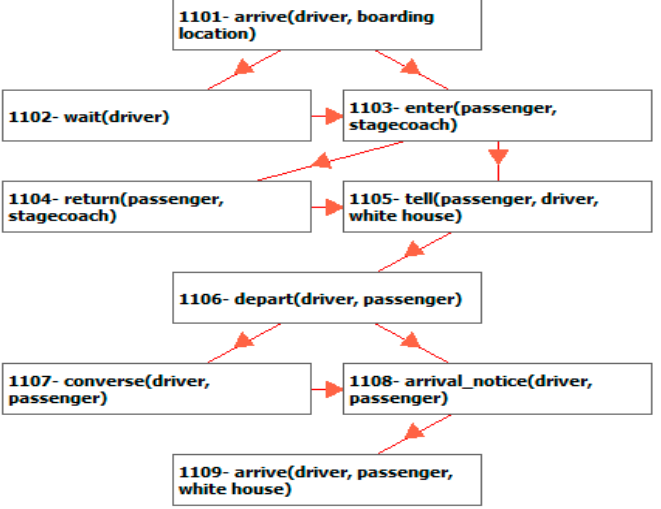
Figure 1. Cognitive script for stagecoach behavior.